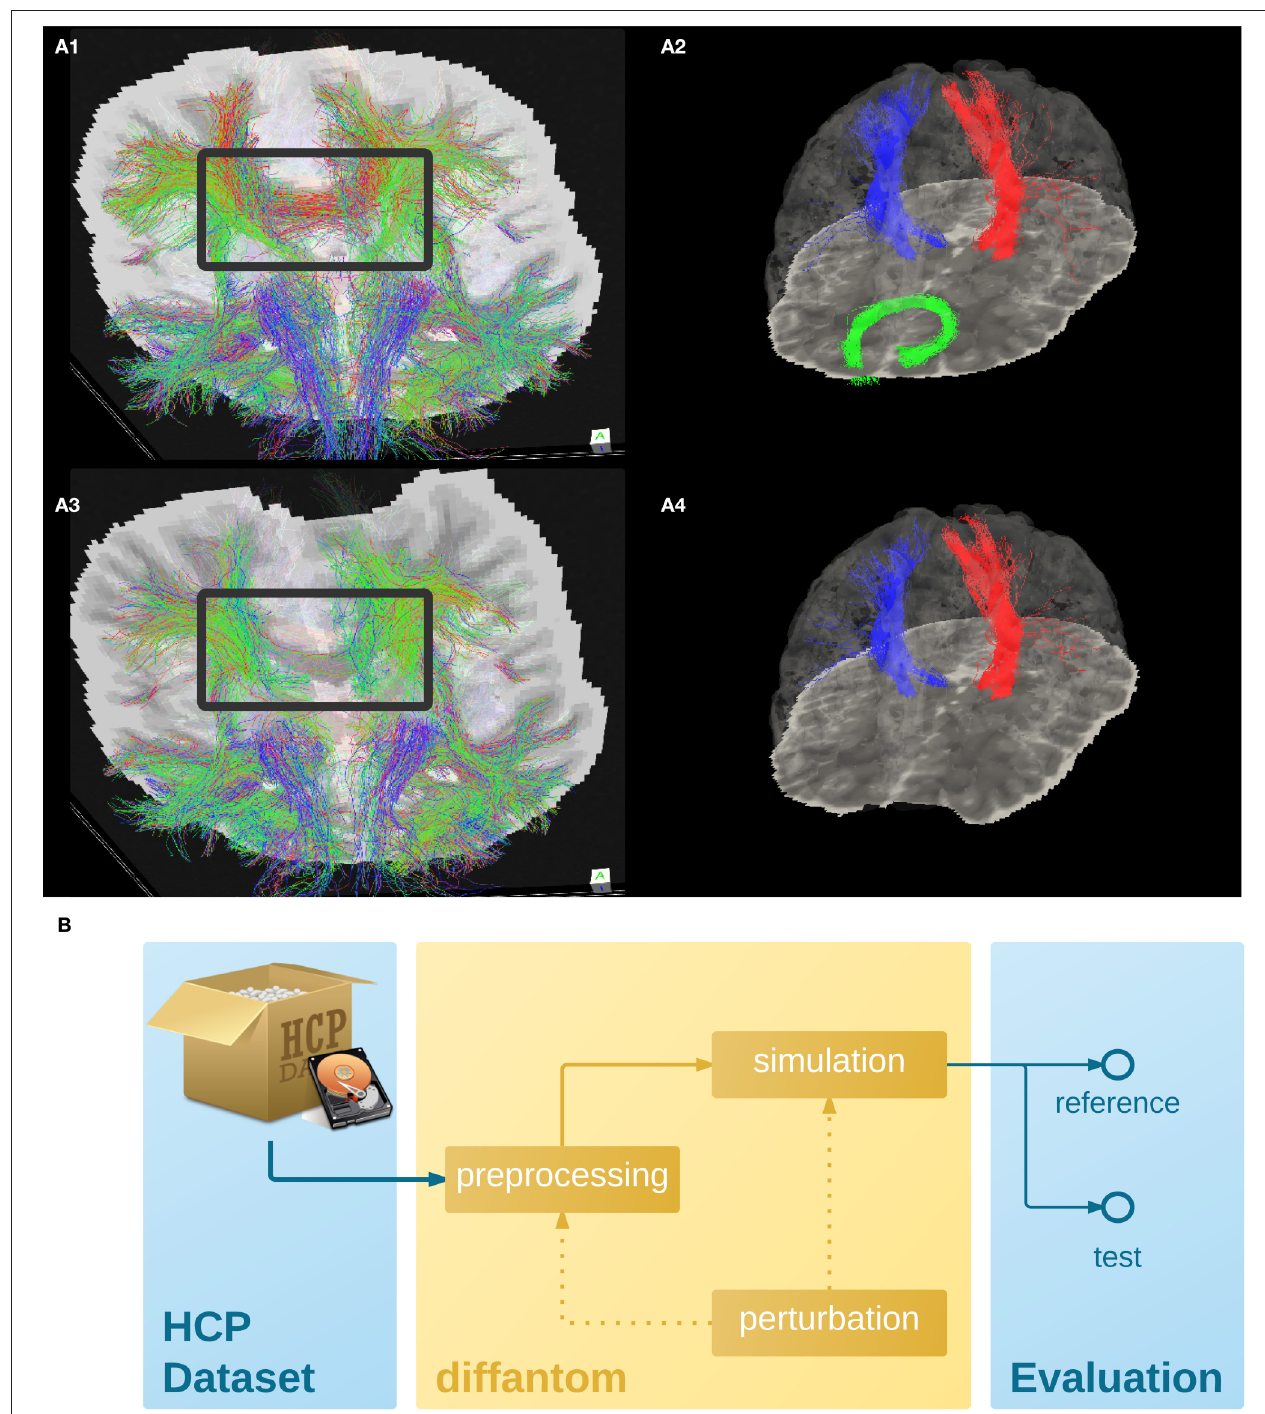
FIGURE 2 | (A) Example dataset. (A1,A3) Shows the tractogram of fibers crossing slice 56 of Diffantom as extracted with MRTrix , represented over the corresponding slice of the b0 volume for the original (A1) and the distorted (A3) phantoms, with a gray frame highlighting the absence of important tracks. Panels (A2,A4) show the segmentation of the right CST represented with blue streamlines, the left CST (red streamlines), and the forceps minor (green streamlines) using tract_querier . (A2,A4) Include the slice 56 of the b0 and the pial surface is represented with transparency (see Supplementary Videos 1,2). In the distorted Diffantom (A4) the forceps minor was not detected. (B) Recommended use of Diffantom . The phantom is designed to be used as ground-truth information in evaluation frameworks, to implement unit test of algorithms, to check integration of processing units within pipelines or to validate complete workflows. For instance, in order to evaluate artifacts, a perturbation can be induced in the microstructural model or after simulation to provide reference and test datasets.